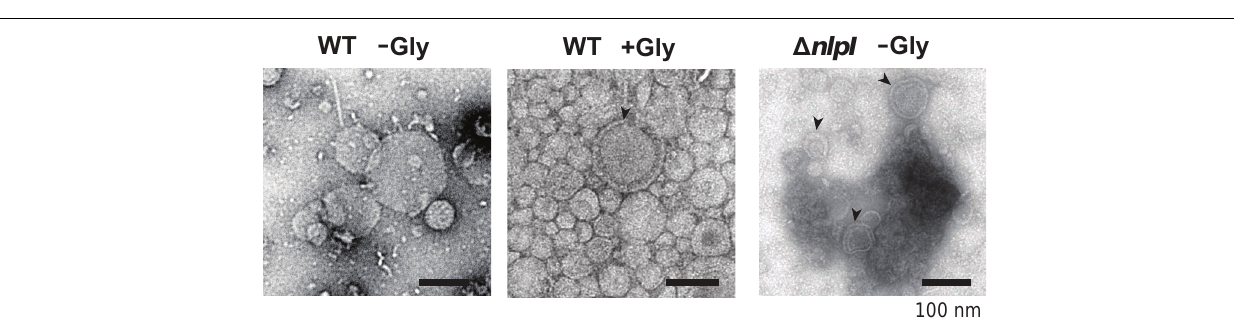
FIGURE 6 | Transmission electron microscopy observation of vesicles. E. coli BW25113 WT and (cid:49) nlpI harboring pUC19 were grown in LB containing ampicillin with or without 1% glycine, and vesicles extracted from the supernatant were observed after negative staining. Bar = 100